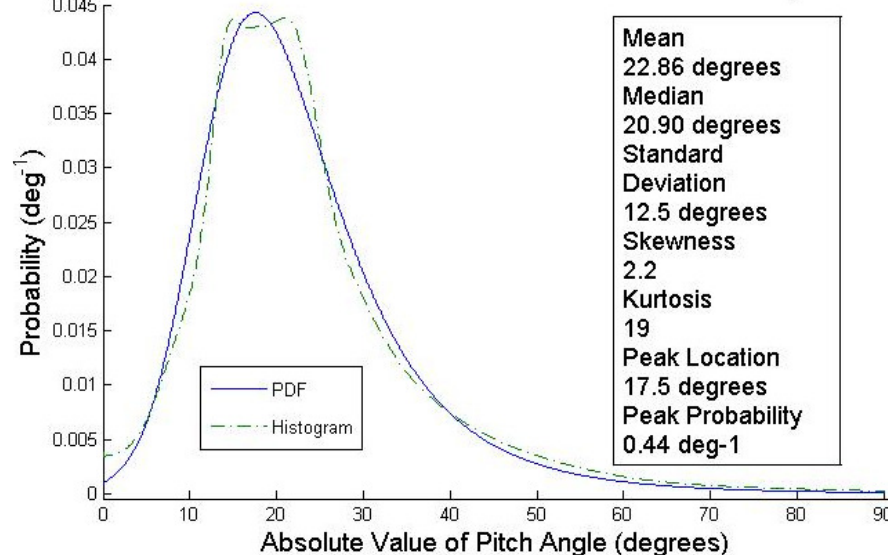
Figure 9. Pitch angle distribution function (PADF) for the faint galaxies sample. The green, dashed- dotted-line distribution ( ) depicts the distribution of | φ | , modeled as a “binless” histogram, where each data point is a Gaussian with mean equal to the measured pitch angle and standard deviation equal to its associated measurement uncertainty. The blue, solid-line distribution ( ) represents the probability density function (PDF) fit. Our best-fit skew-kurtotic-normal distribution to the data is shown. The faint galaxies sample shows higher skewness and kurtosis than its higher- luminosity counterpart (cf. [53], Figure 6), indicating data points with larger associated uncertainties and a heavier tail to the distribution. This graph was generated using the R package PEARSON _ DS